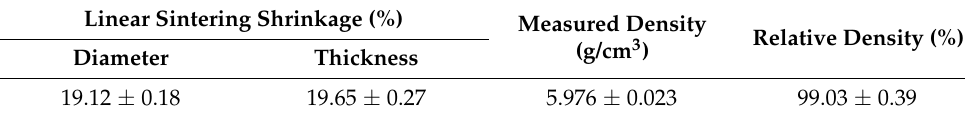
Table 3. Linear sintering shrinkages and relative densities of 5Y-PSZ disks after sintering at 1500 °C for 2 h.